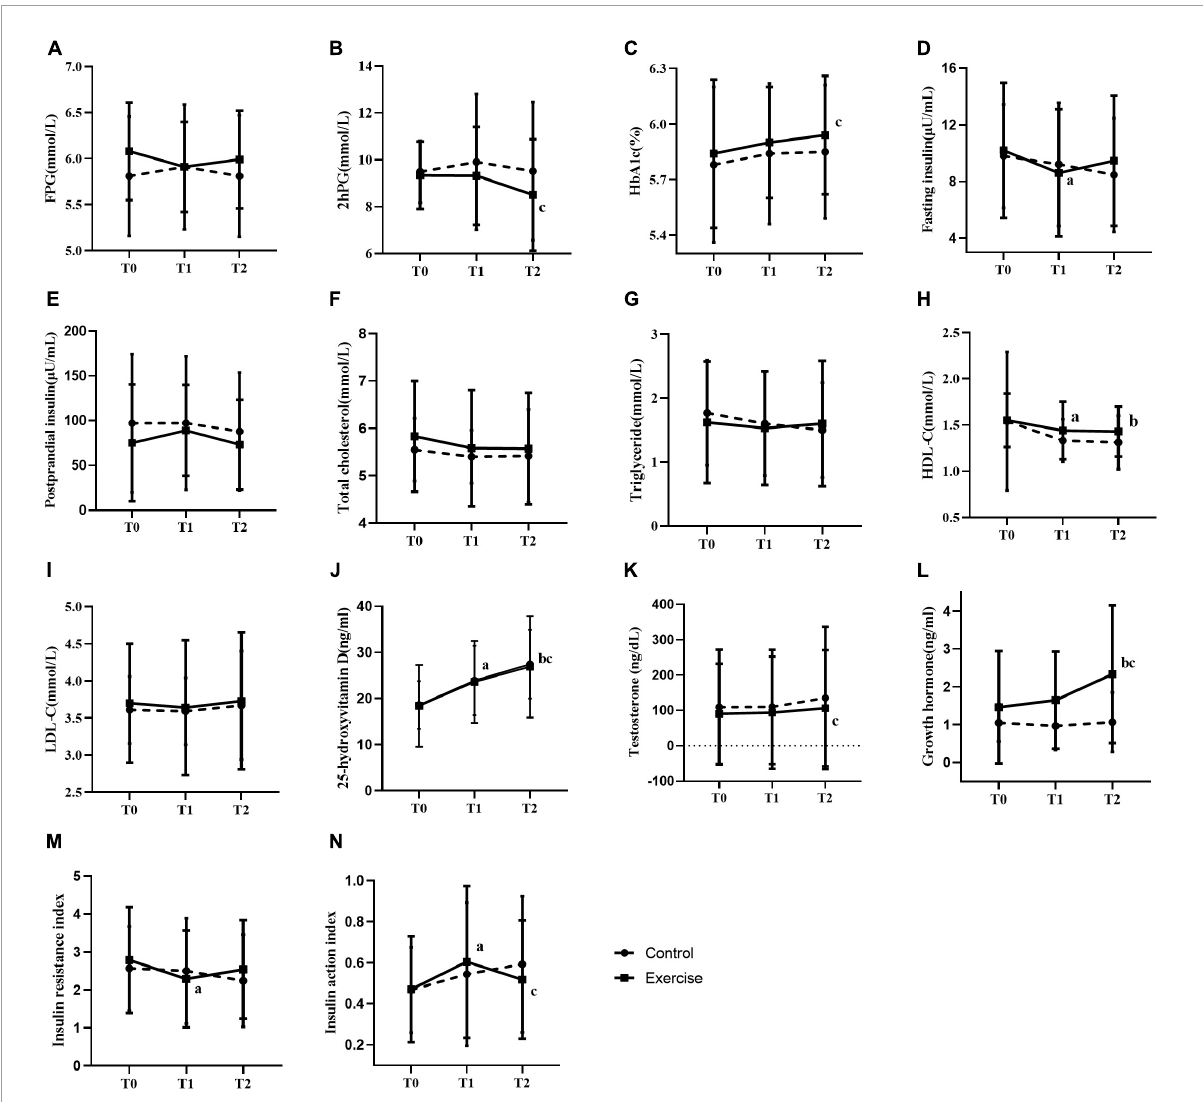
FIGURE3 Effect of exercise on glucose and lipid metabolism. (A–N) Fasting blood-glucose (A) , 2–hour post-meal blood glucose (B) , glycated hemoglobin% (C) , fasting insulin (D) , postprandial serum insulin (E) , total cholesterol (F) , triglyceride (G) , high density lipoprotein cholesterol (H) , low density lipoprotein cholesterol (I) , 25–hydroxyvitamin D (J) , testosterone (K) , growth hormone (L) , insulin resistance index (M) , insulin action index (N) . a: significant difference between baseline and the 3rd month in the same group; b: significant difference between baseline and six months in the same group; c: significant difference between 3 months and 6 months in the same group. T0, T1, and T2 represent baseline, 3 months, and 6 months respectively. * represents p < 0.05 and ** represents p <